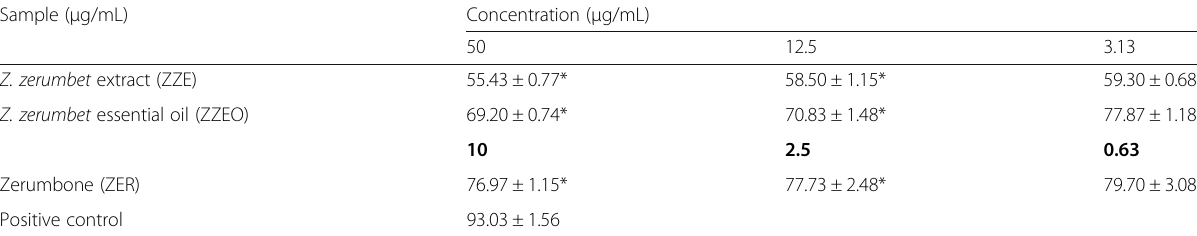
Table 3 Percentage of phagocytic activity (%) of neutrophils at different concentrations of test samples derived from Zingiber zerumbet